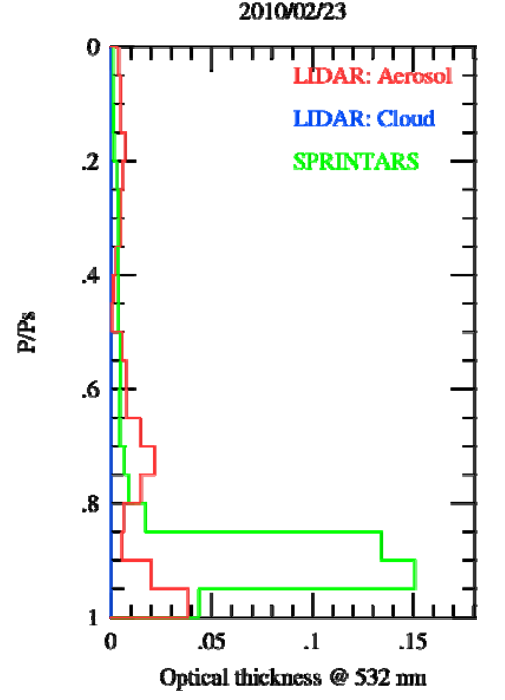
Fig. 8. Vertical profiles of aerosol optical thickness measured by li- dar and simulated by SPRINTARS at 532nm on 23 February 2010. Fig. 8.